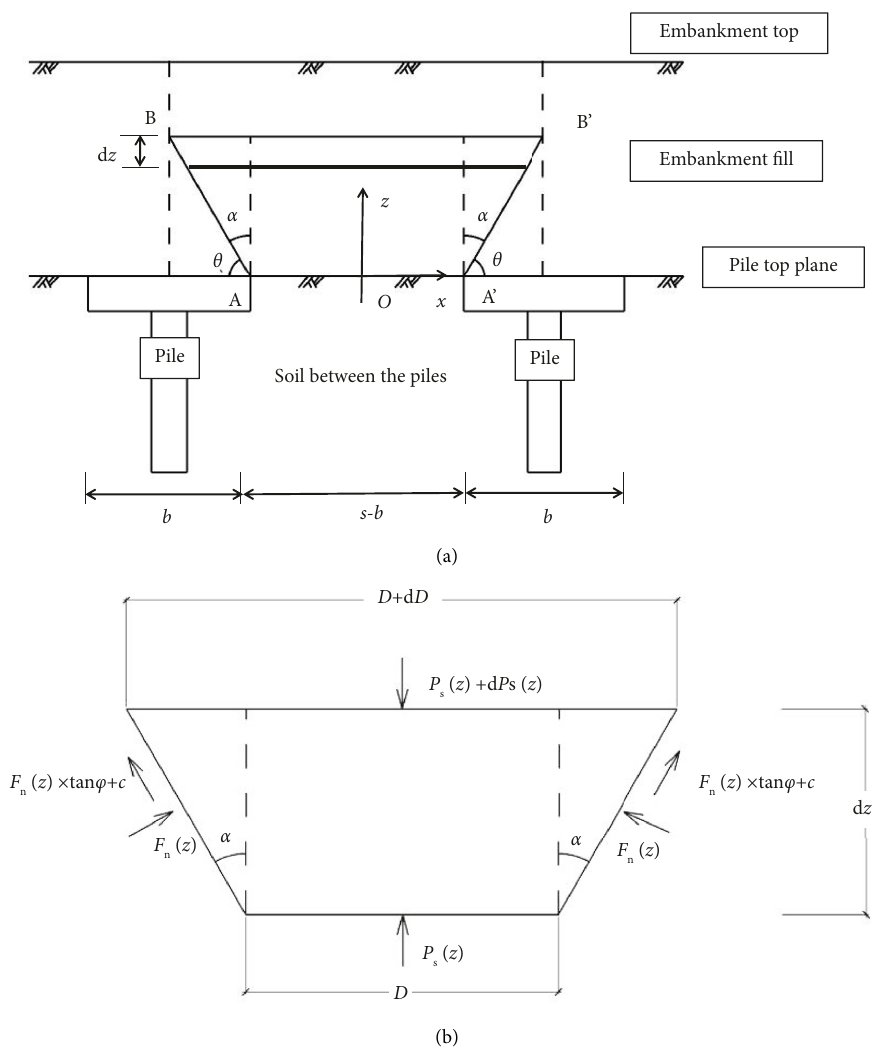
Figure 12: (a) A schematic diagram of the theoretical model and (b) force equilibrium of segment d ( z ).